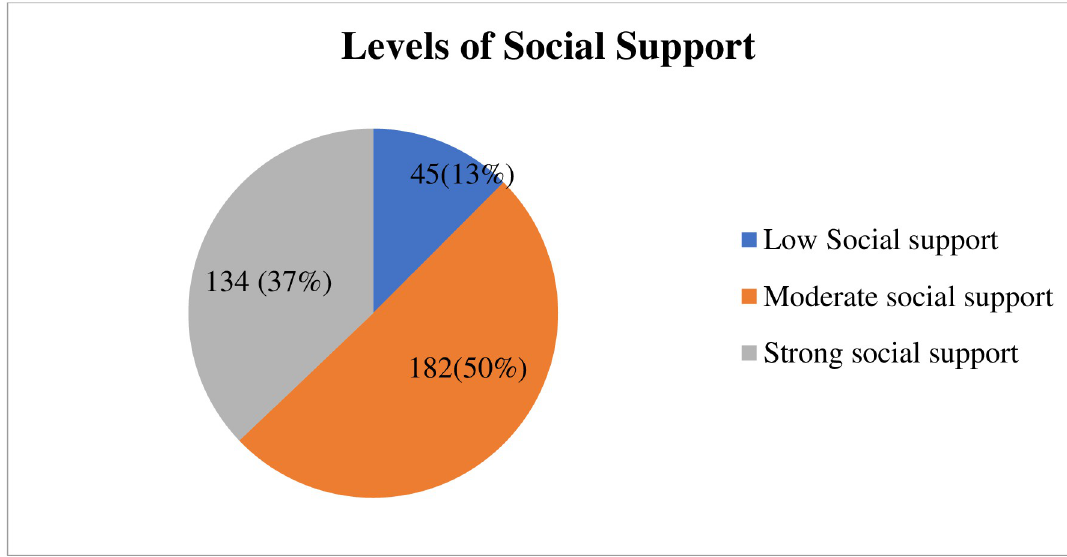
Fig 3. Showing social support level among DMU SMCHS students on mental distress North West, Ethiopia, 2021 (N = 461).